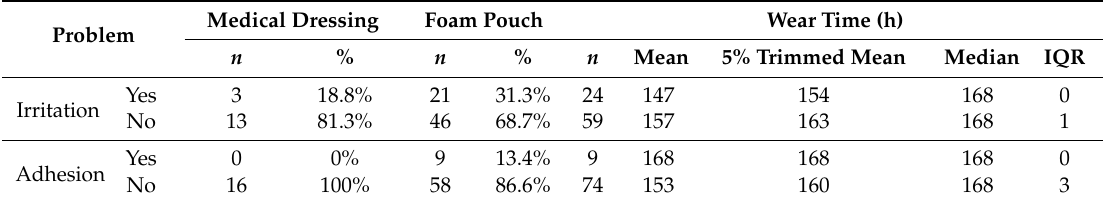
Table 1. Irritation and adhesion problems experienced in the adult sample while wearing dual Axivity AX3 accelerometers.